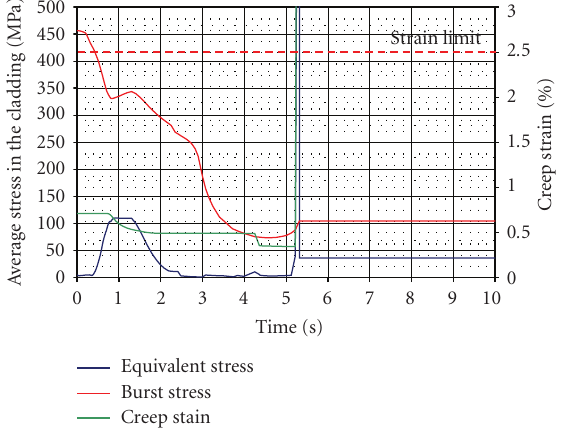
Figure 10: Outer fuel and inner cladding radius, contact, gap, and coolant pressure as a function of time, Rod 267 BL21 slice #3.